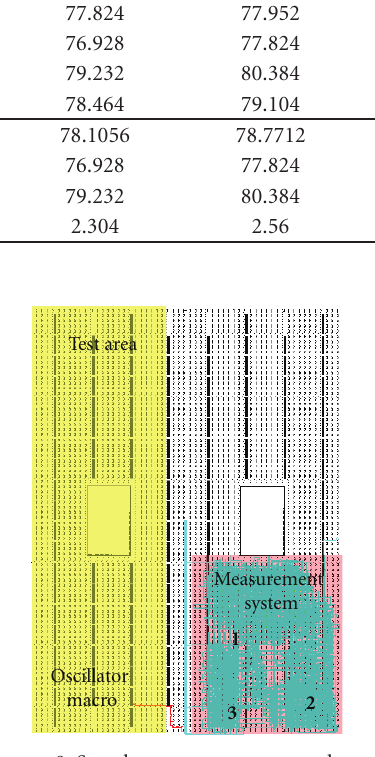
Figure 8: Speed measurement system